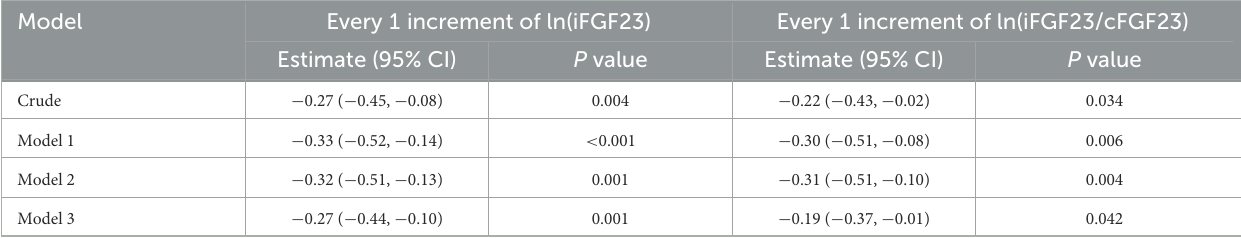
TABLE 3 Association between FGF23 and serum hemoglobin level in patients on chronic hemodialysis.